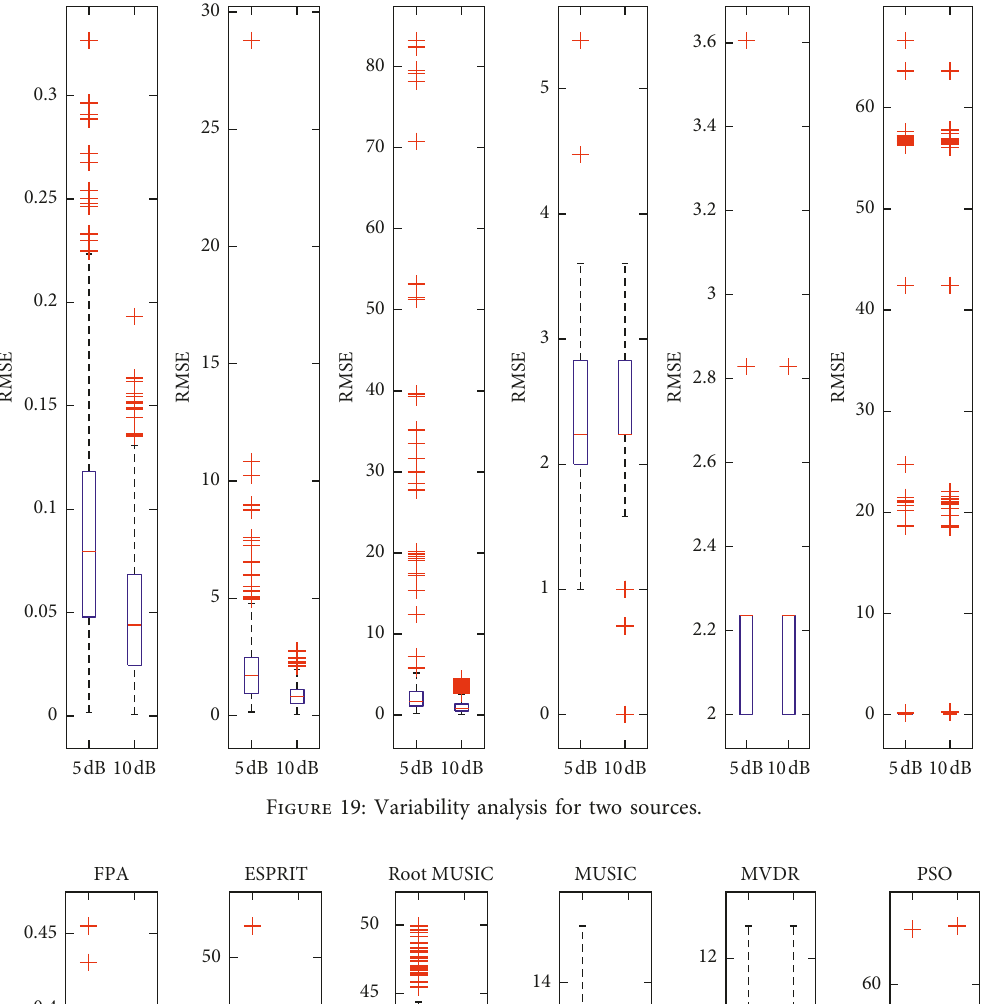
Figure 19: Variability analysis for two sources.